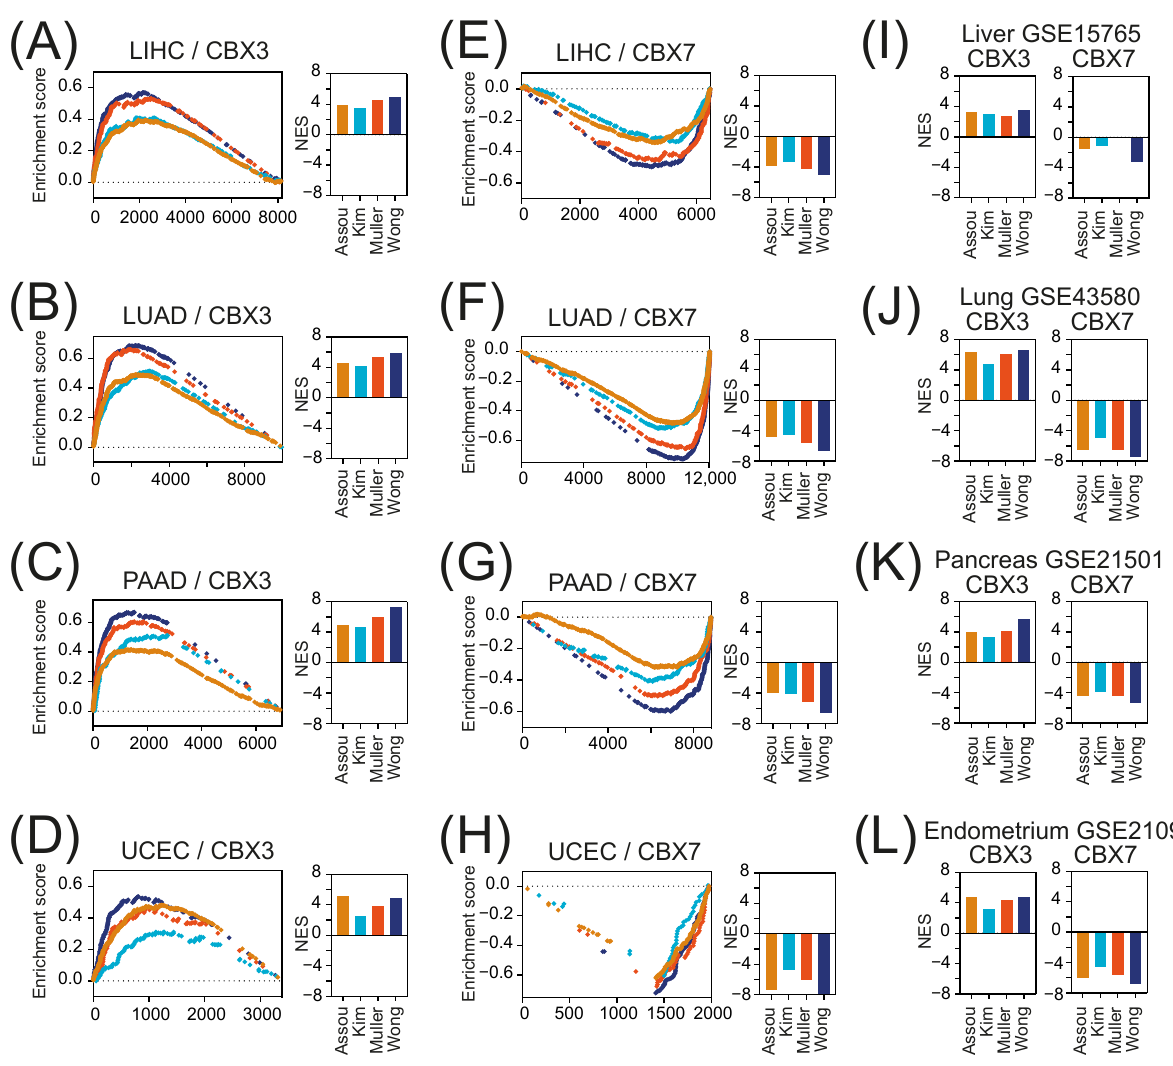
Figure 6. Stemness gene signatures in CBX3- and CBX7-associated transcriptome profiles. ( A – D ) The GSEA of all significantly correlated genes to CBX3 revealed significant enrichment ( p < 0.0001) of stemness-associated gene signatures (Assou_ESC_, Kim_Myc, Muller_Plurinet, Wong_ESC_core) in ( A ) LIHC, ( B ) LUAD, ( C ) PAAD, and ( D ) UCEC. The normalized enrichment score (NES) for each gene signature is plotted in the bar graph. ( E – H ) Similarly, the GSEA of all significantly correlated genes to CBX7 revealed significant depletion ( p < 0.0001) of stemness-associated gene signatures (Assou_ESC_, Kim_Myc, Muller_Plurinet, Wong_ESC_core) in ( E ) LIHC, ( F ) LUAD, ( G ) PAAD, and ( H ) UCEC. The normalized enrichment score (NES) for each gene signature is plotted in the bar graph. ( I – L ) Accordingly, the GSEA of all significantly correlated genes to CBX3 (left panel) or CBX7 (right panel) revealed significant enrichment or depletion of stemness-associated gene signatures, respectively, in ( I ) liver GSE15765, ( J ) lung GSE43580, ( K ) pancreatic GSE21501, and ( L ) endometrial carcinoma